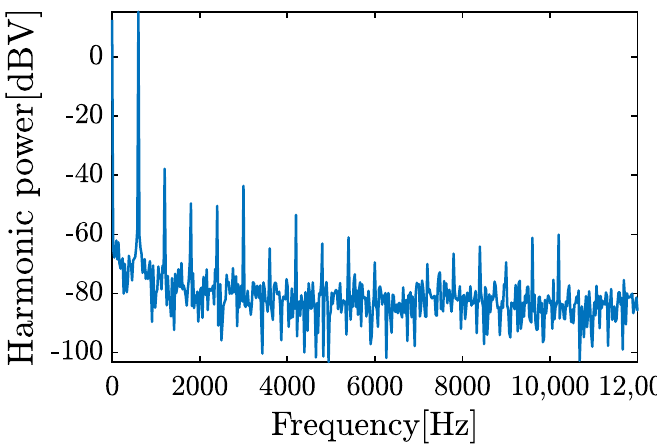
Figure 18. Power spectral density of the modulation voltage.